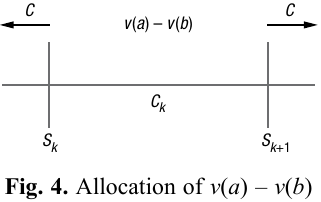
Fig. 4. Allocation of v ( a ) – v ( b